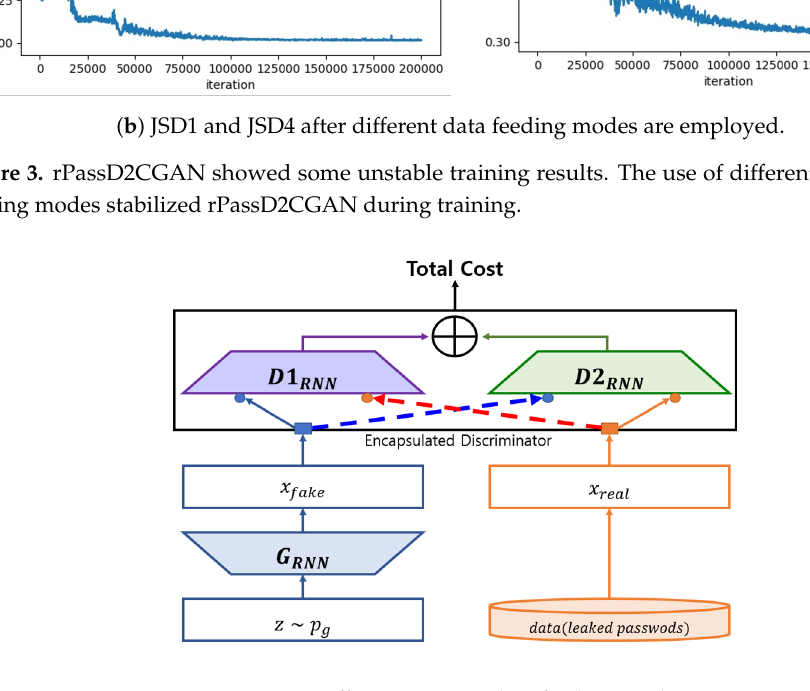
Figure 4. Different training data feeding